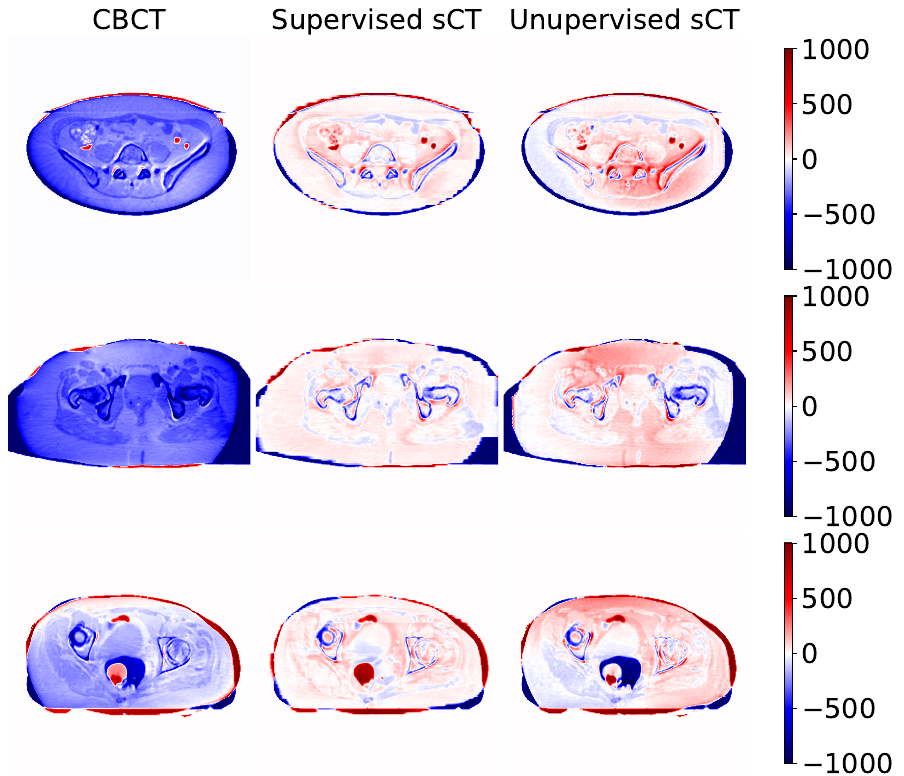
Figure 7. Difference maps computed between original CBCT, sCT supervised, and sCT unsupervised using their corresponding CT as reference. Numeric values are in Hounsfield Units. Each row represents a different example taken from a different subject. The examples depicted in this figure correspond to the example presented in Figure